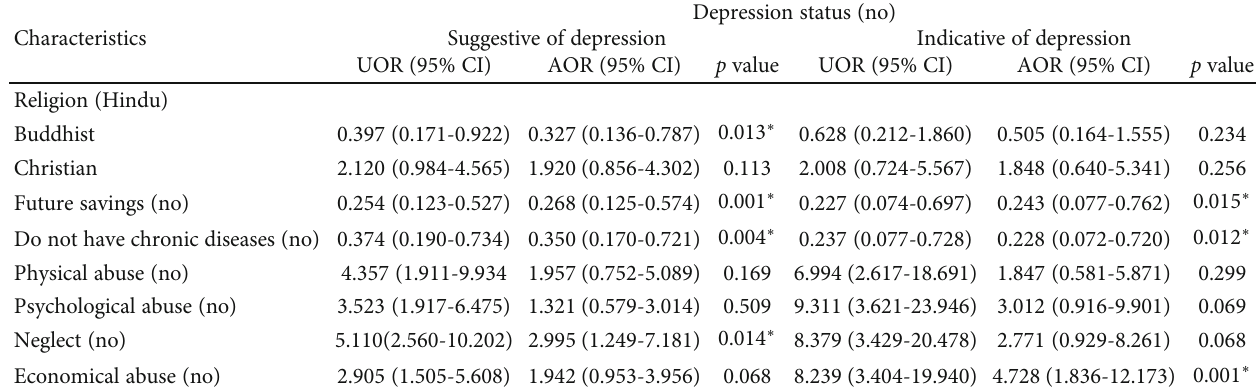
Table 4: Multinomial regression analysis of factors associated with